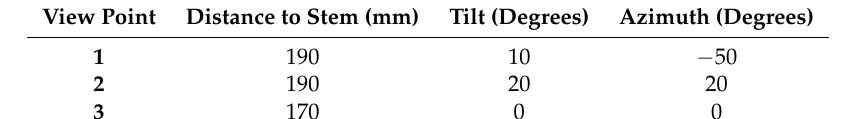
Figure 5. Experimental setup including a robotic arm, equipped with an RGBD camera and an illumination rig. Table 2. Viewpoints description.